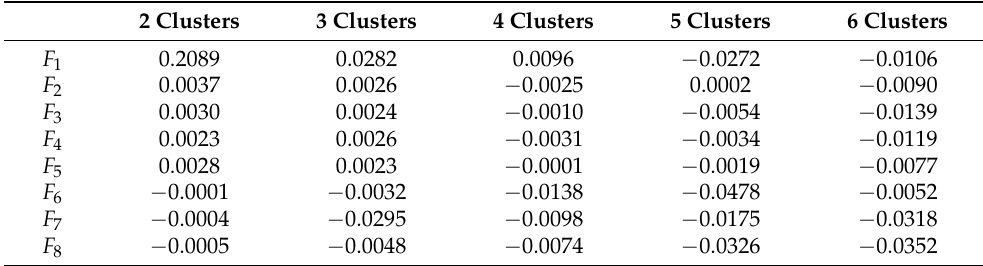
Table 7. Difference in processing time between k-means and fuzzy